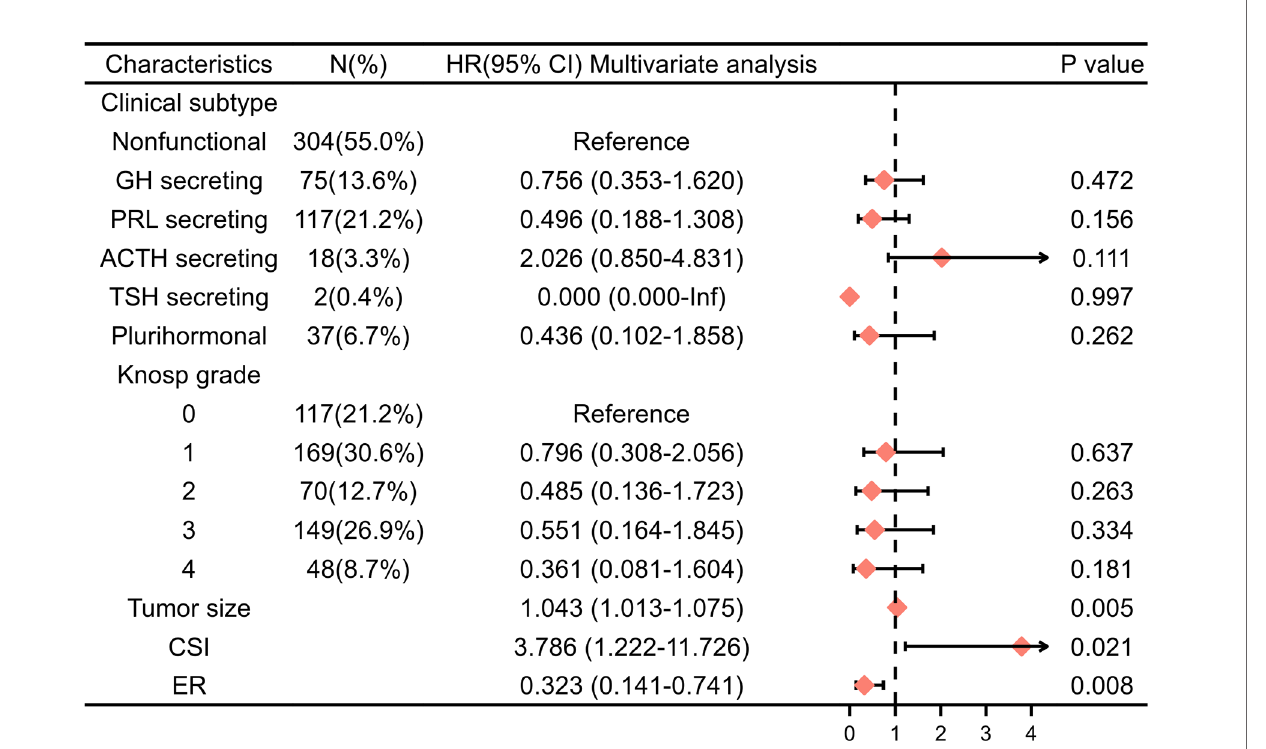
FIGURE 3 | Multivariable Cox regression analysis of PFS in the training cohort. HR, hazard ratio; CI, con fi dence interval; PRL, prolactin; GH, growth hormone; ACTH, adrenocorticotropic hormone; TSH,thyroid-stimulating hormone; CSI, cavernous sinus invasion; ER, extracapsular